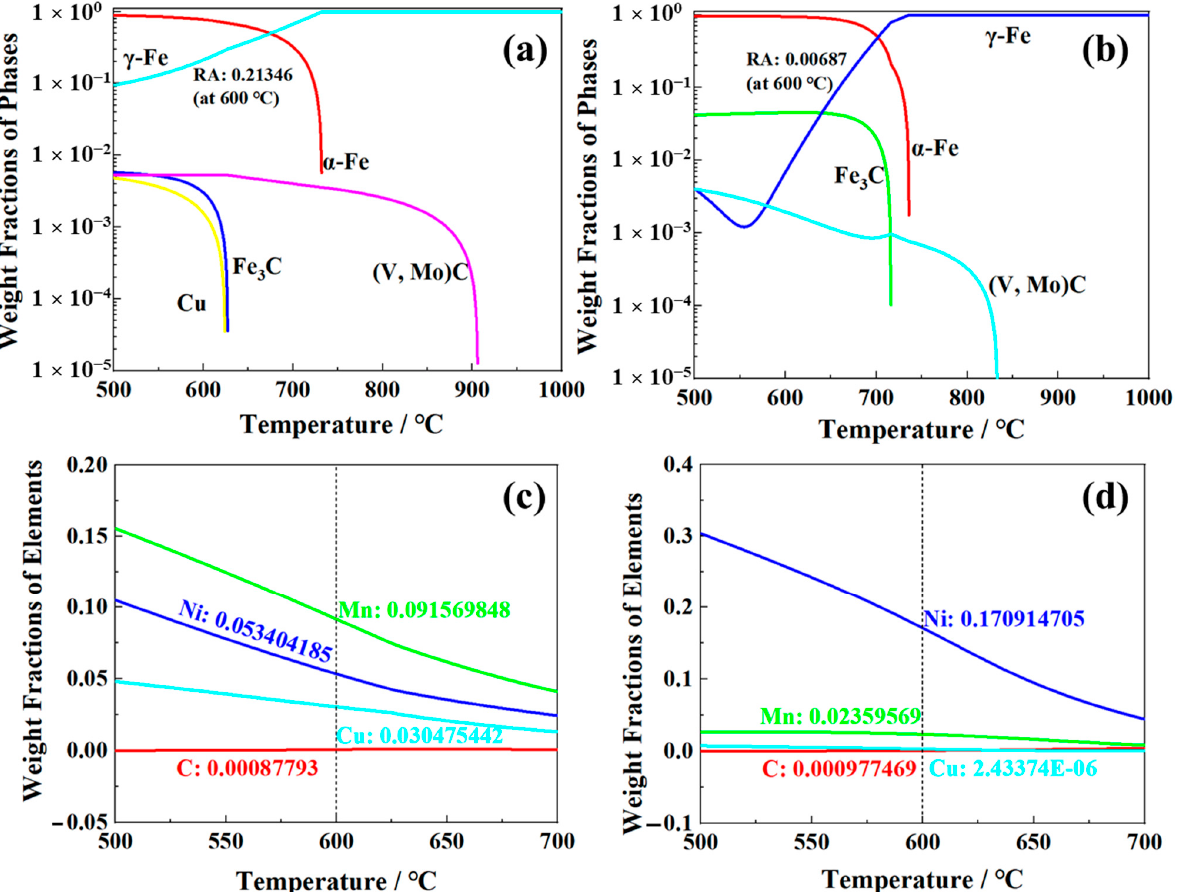
Figure 11. Thermo-Calc calculations: phase weight fractions of ( a ) 0.12C-3.13Mn steel and ( b ) S4330 steel; element weight fractions in RA of ( c ) 0.12C-3.13Mn steel and ( d ) S4330 steel, respectively. C, Mn, Ni, and Cu are all the elements used to enlarge the austenite single-phase